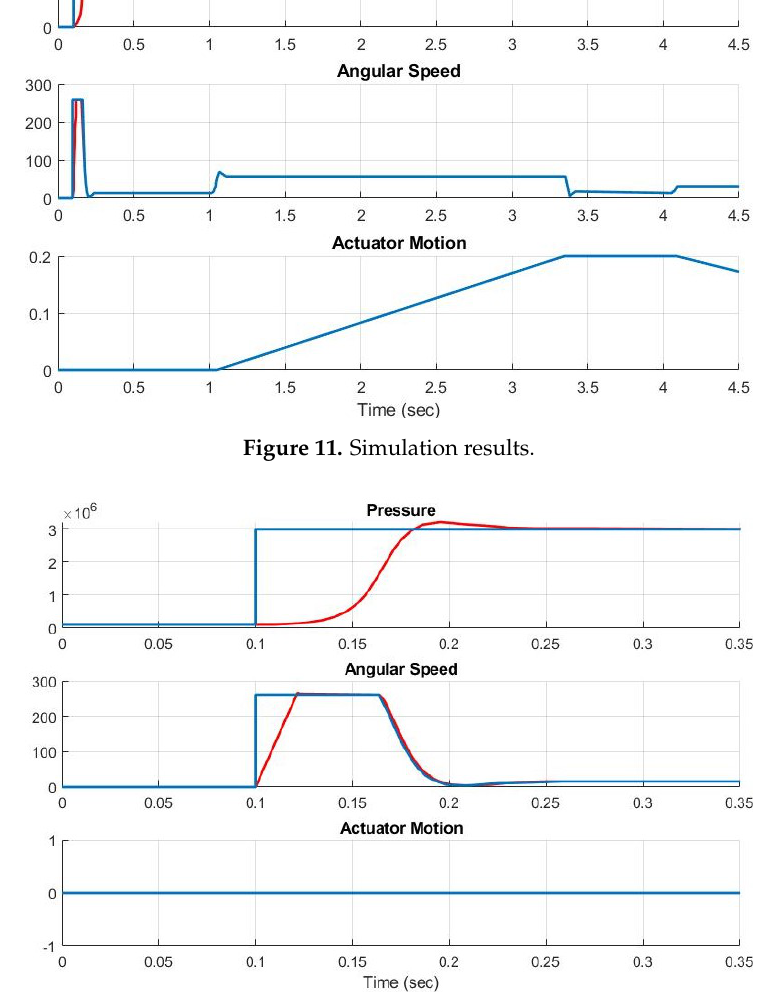
Figure 12. Zoomed view of pressure